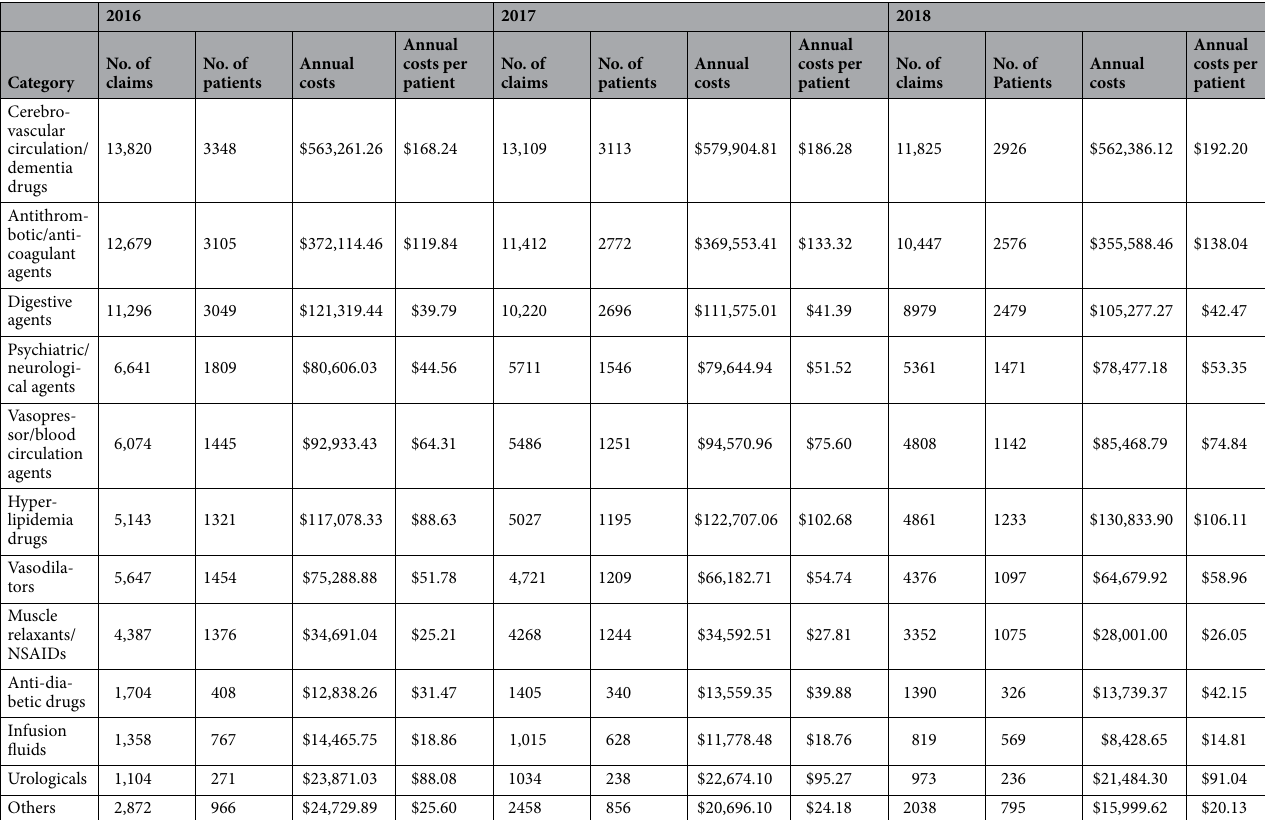
Table 3. Prescription and medicine costs (Total). All costs were converted using the annual average exchange rate (KRW/USD) of the corresponding year. The price level of healthcare cost is adjusted for 2018 (see Supplementary Table 5). NSAIDs: nonsteroidal anti-inflammatory